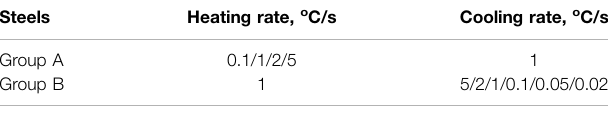
TABLE 3 | The transformation points of the NSM steel when heated at different rates. Heating rates, o C/s